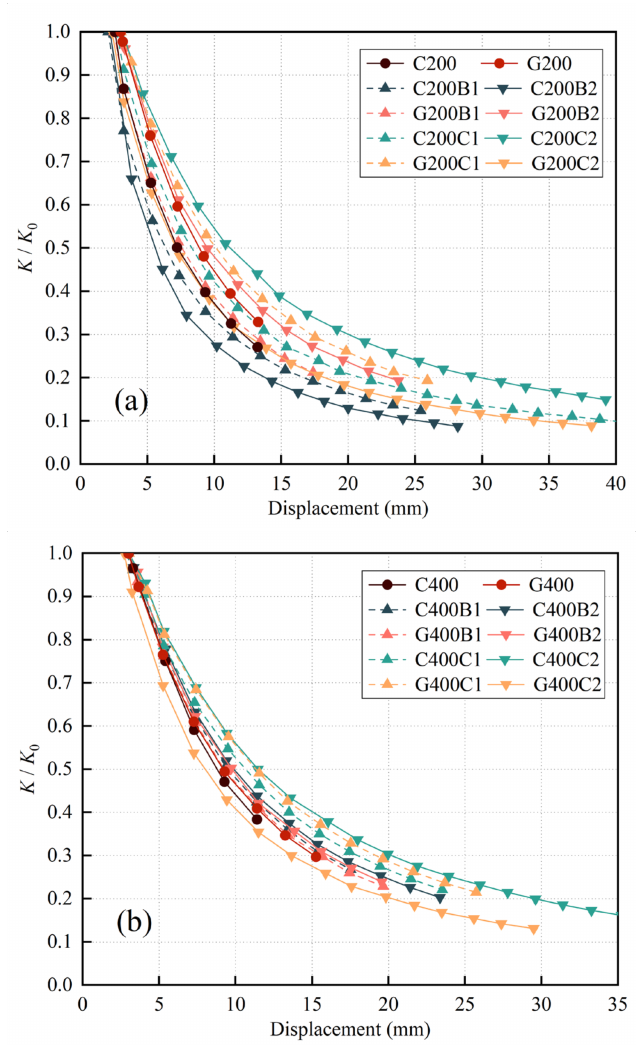
Figure 10. Stiffness degradation ratio: ( a ) Specimens 200 mm high; ( b ) Specimens 400 mm